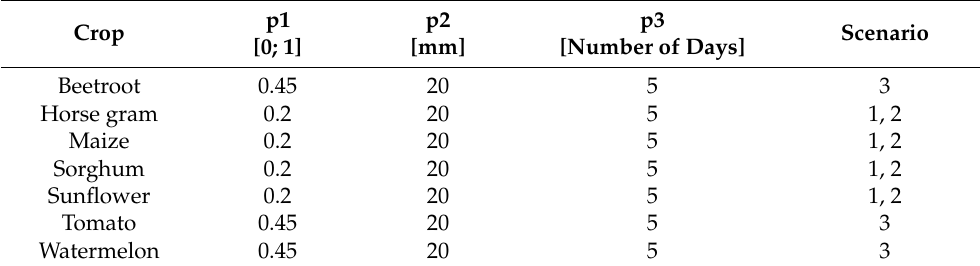
Table 2. Crop parameters regarding crop water stress (see A3 for